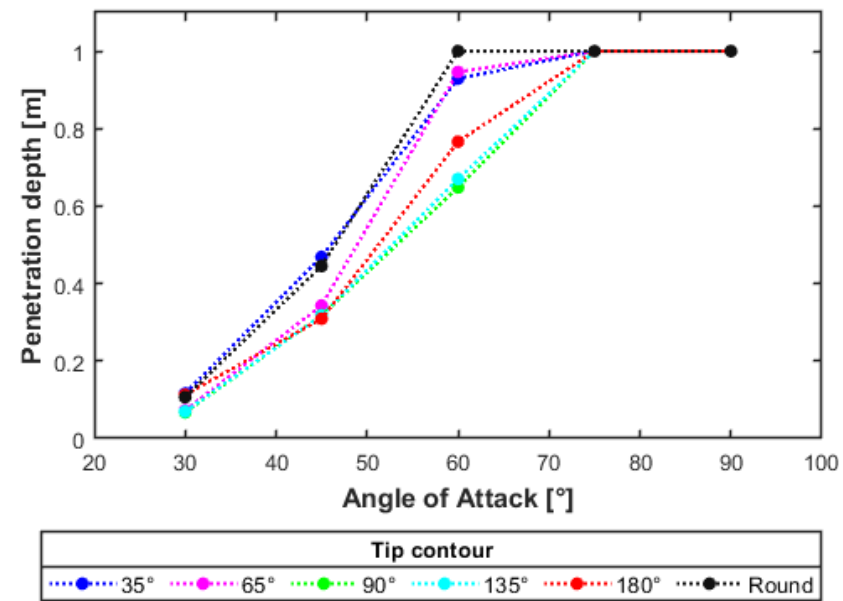
Figure 4. Penetraion vs. AoA.